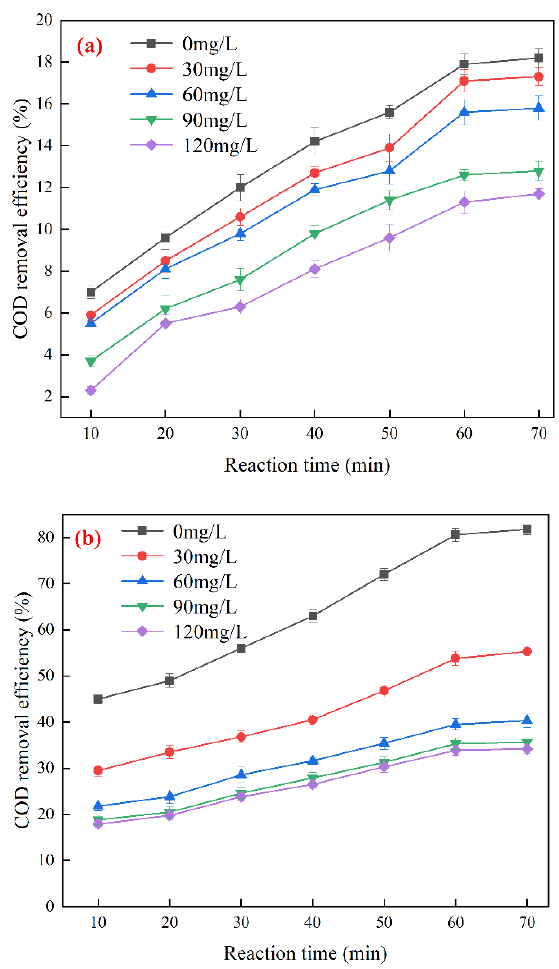
Figure 7. Effect of TBA dosage on COD removal efficiency: ( a ) ozone system, ( b ) ozone catalytic oxidation system.